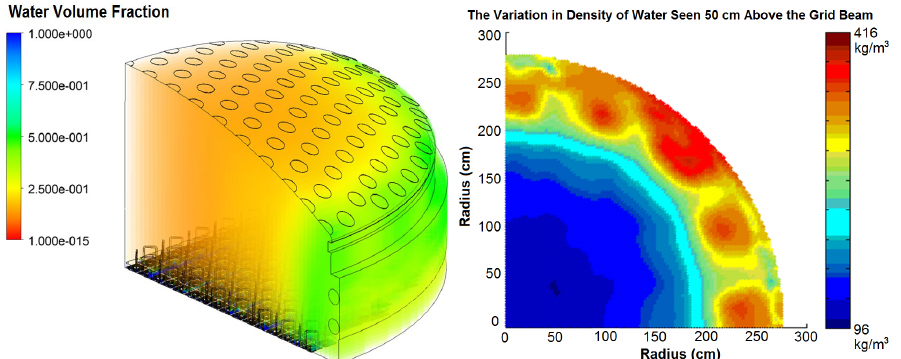
Fig. 2. (Left) Example of CFD determined water volume fraction distribution. High density steam is observed between the top guide and the outer fuel bundles. (Right) Plot showing the radial and azimuthal variation of water density at an elevation 50 cm above the grid